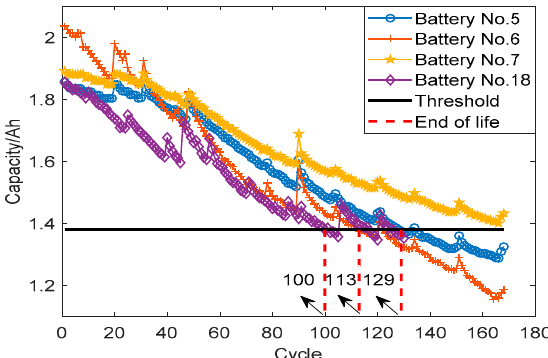
Figure 1. Capacity degradation curves of batteries.